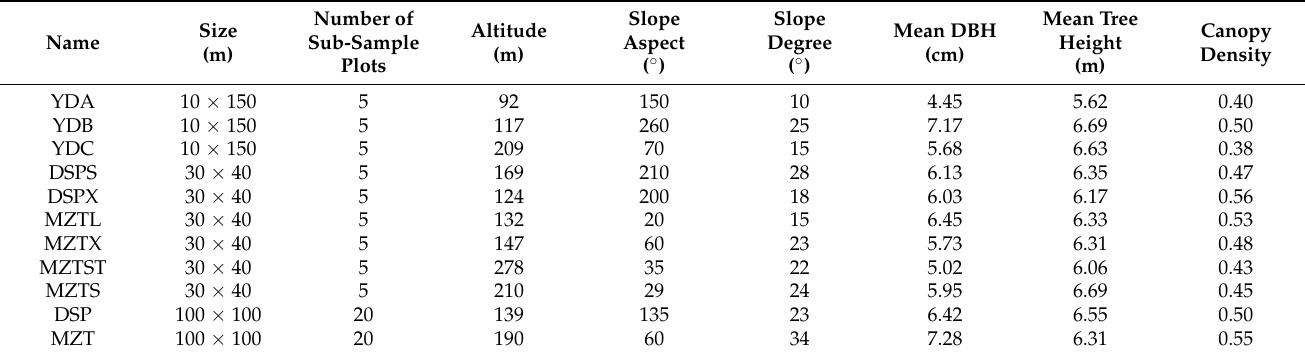
Table 1. The basis information of sample